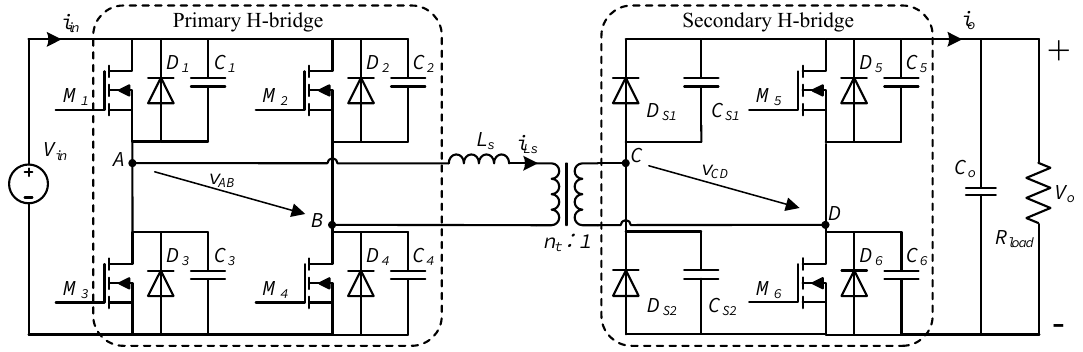
Figure 1. The circuit configuration of a S-DAB